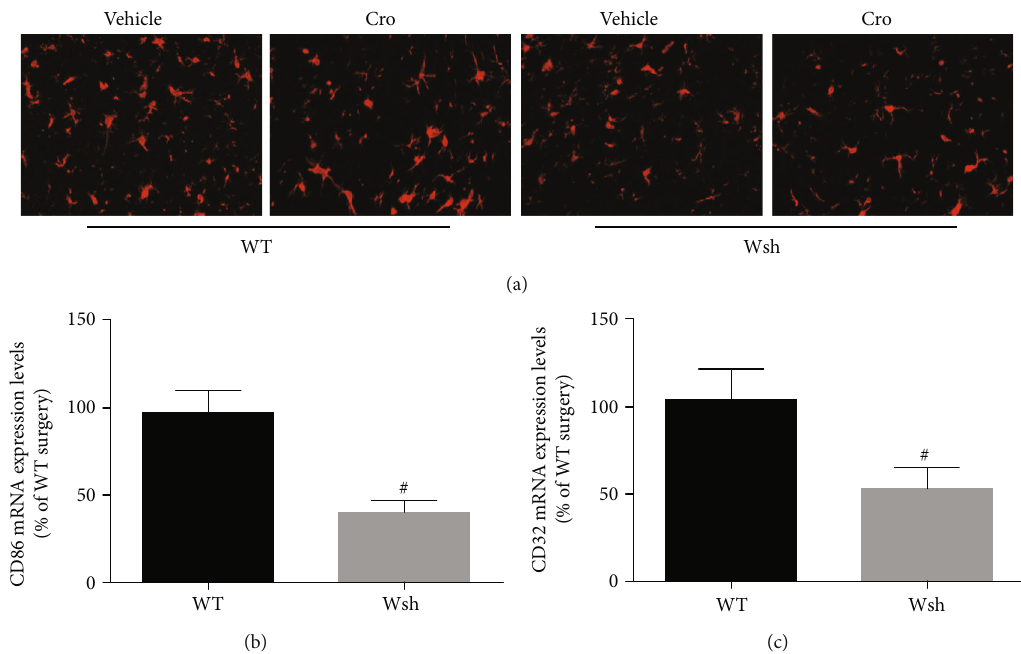
Figure 4: Microglial activation in the hippocampus was inhibited by mast cell stabilization and de fi ciency. (a) Iba1 in area CA1 of the hippocampus was detected by immunostaining. Scale bar is 25 μ m. (b, c) Expression levels of CD86 and CD32 (M1 phenotype markers) at 1 day after surgery were measured by real-time PCR. # P < 0 : 05 versus WT group. Data are presented as the mean ± SEM ( n = 5 ).